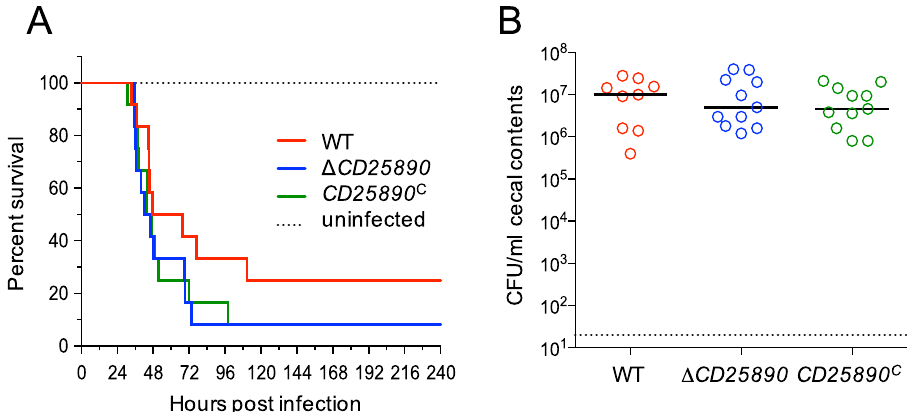
Figure 7. The (cid:31) CD25890 mutant show no differences in virulence. ( A ) and ( B ) Syrian golden hamsters were inoculated with approximately 5000 spores of strain 630∆ erm (n = 12), CD25890 (n = 12), or CD25890 C (n = 12). ( A ) Kaplan–Meier survival curve depicting time to morbidity. Mean times to morbidity were: 630∆ erm 56.6 ± 8.2 (n = 9); CD25890 48.7 ± 4.5 (n = 11); CD25890 C 49.8 ± 5.8 (n = 11). ( B ) Total C. difficile CFU recovered from cecal contents collected post-mortem. Dotted line demarcates limit of detection. Solid black line marks the median. Numbers of CFU are compared to 630∆ erm by one-way ANOVA with Dunnett’s multiple comparisons test. No statistically differences were